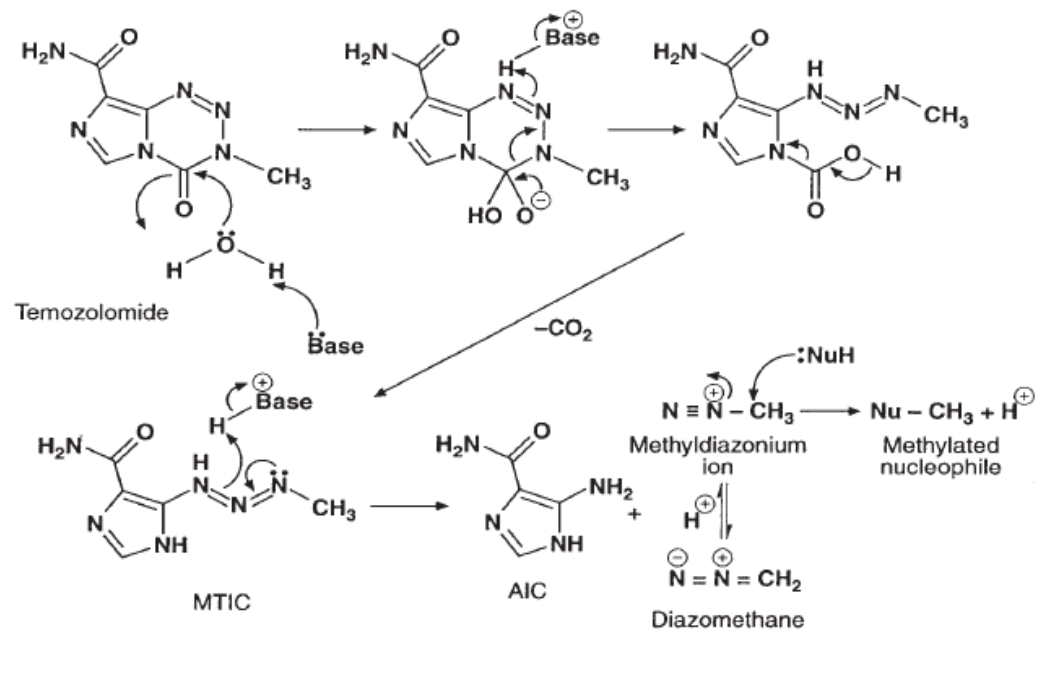
Figure 1 . Metabolism of temozolomide to its active